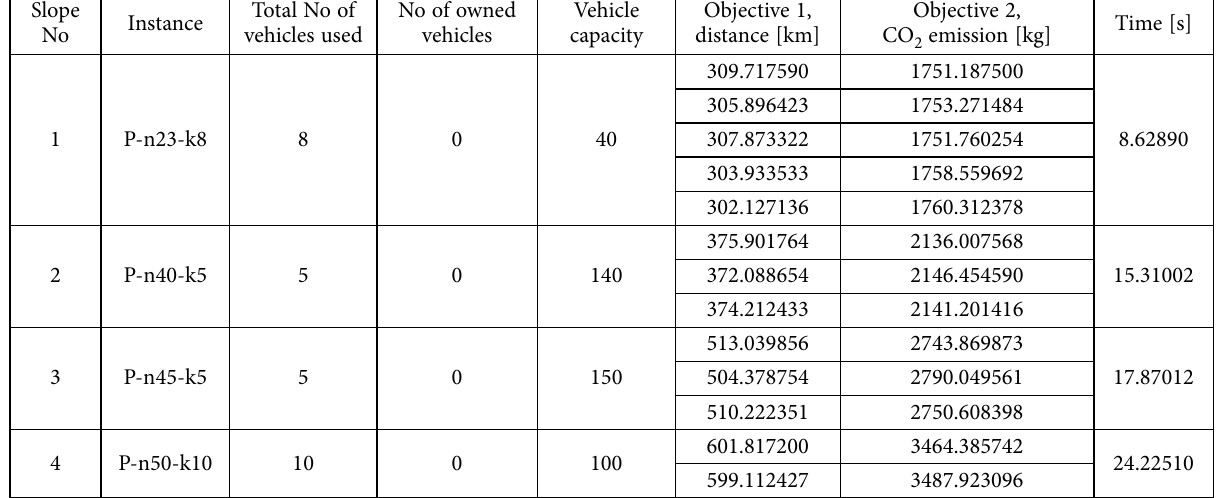
Table 2. Results of independent runs of the multi-objective fully open